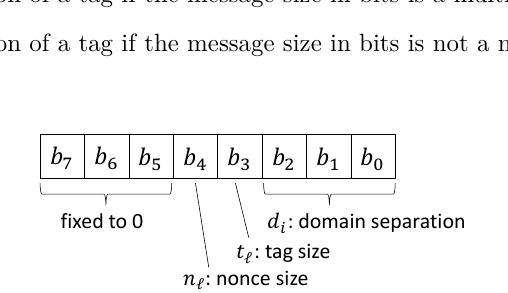
Figure 2: Domain separation and distinction of the different